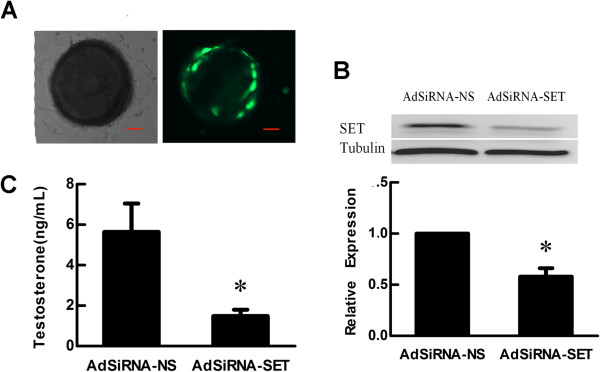
Effect of SET knockdown on testosterone synthesis in theca cells. (A) Infection of follicular theca cells with recombinant adenoviruses. Follicles were infected with recombinant adenovirus AdSiRNA-SET or AdSiRNA-NS and cultured for 24 h. The majority of theca cells were infected as judged by the expression of GFP under a fluorescence microscope. Left: light microscope; right: fluorescence microscope (Scale bar = 50 μm). (B) Western blot analysis of SET protein expression in follicles infected with recombinant adenovirus for 48 h. The levels of SET protein in follicles infected with AdSiRNA-SET were decreased about 43% compared with follicles infected with AdSiRNA-NS. (C) Effect of SET knockdown on theca cell testosterone synthesis. Compared with the follicles infected with AdSiRNA-NS, the amount of testosterone in the culture media of the AdSiRNA-SET infection group was significantly degraded. Results are presented as Mean ± SD from at least 3 independent experiments. Sample sizes were 20 follicles per treatment, per experiment. *, p < 0.05 compare with AdSiRNA-NS infected group.